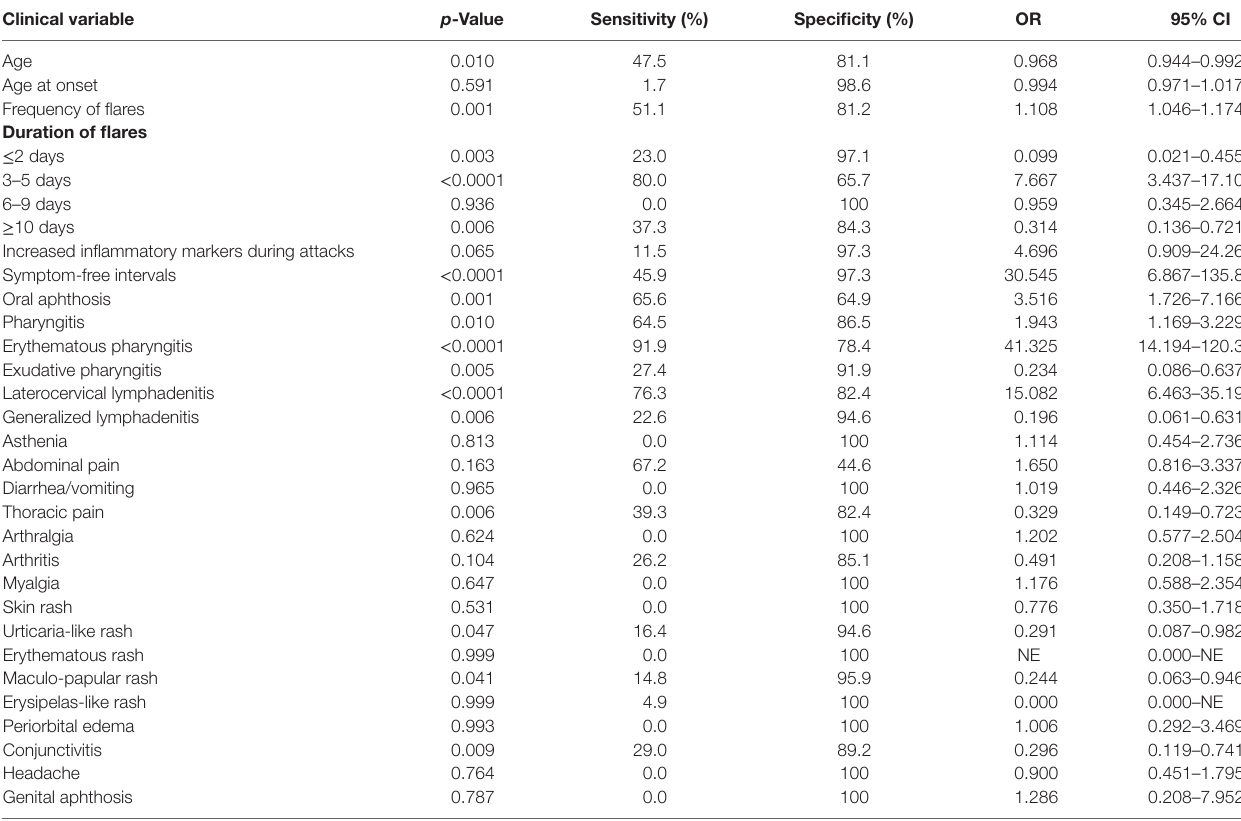
TaBle 2 | Results of univariate logistic regression analysis performed on adult-onset periodic fever, aphthous stomatitis, pharyngitis, and cervical adenitis (PFAPA) patients and subjects with fever of unknown origin by evaluating clinical manifestations described in both